Question: What direction does the quantity move in — increasing or decreasing?
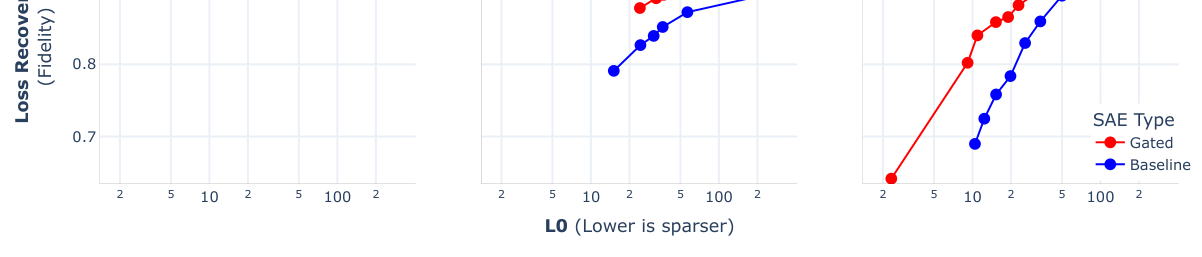
Answer: increasing